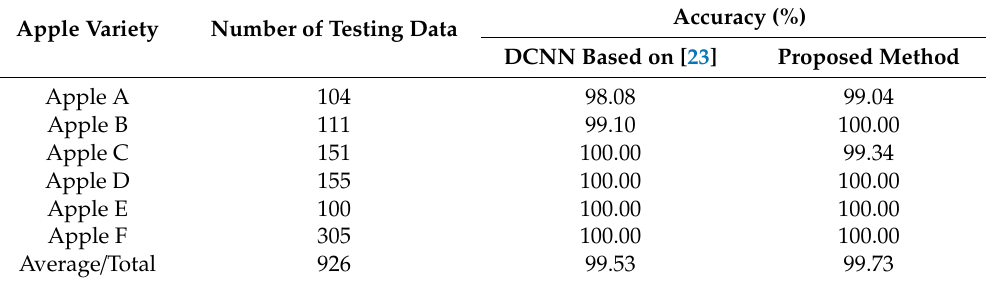
Table 11. Comparison of the two methods based on